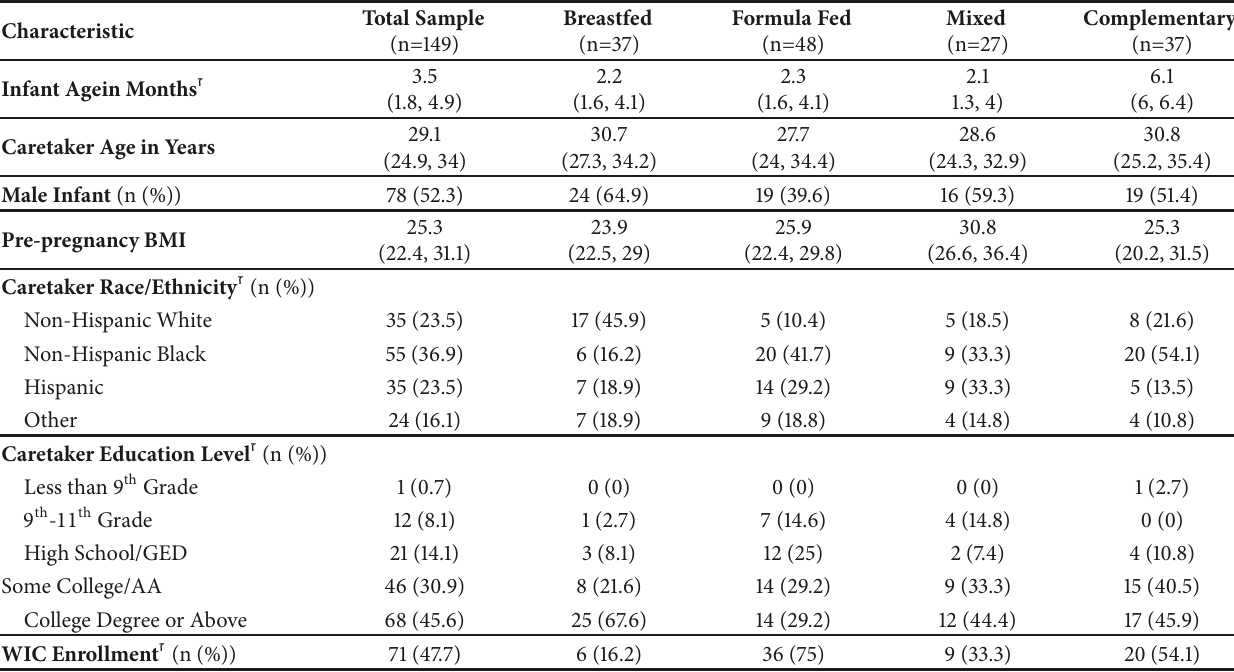
Table 1: Demographic characteristics of infants and caretakers by feeding type at time of questionnaire completion (n=149).